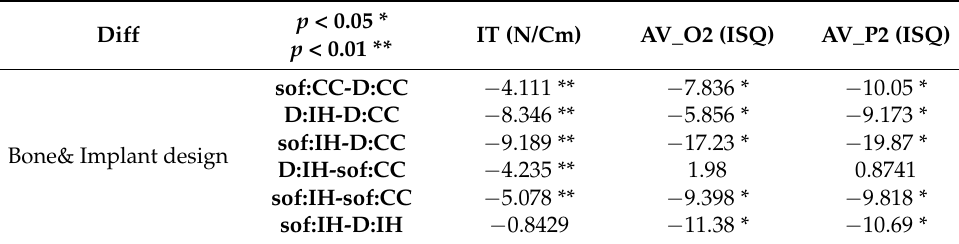
Table 2. The difference of average implant stability measurements between the tested parameters of bone type (soft or dense) and implant type (IH or CC) by the IT, Osstell (O2), and Penguin (P2) devices.